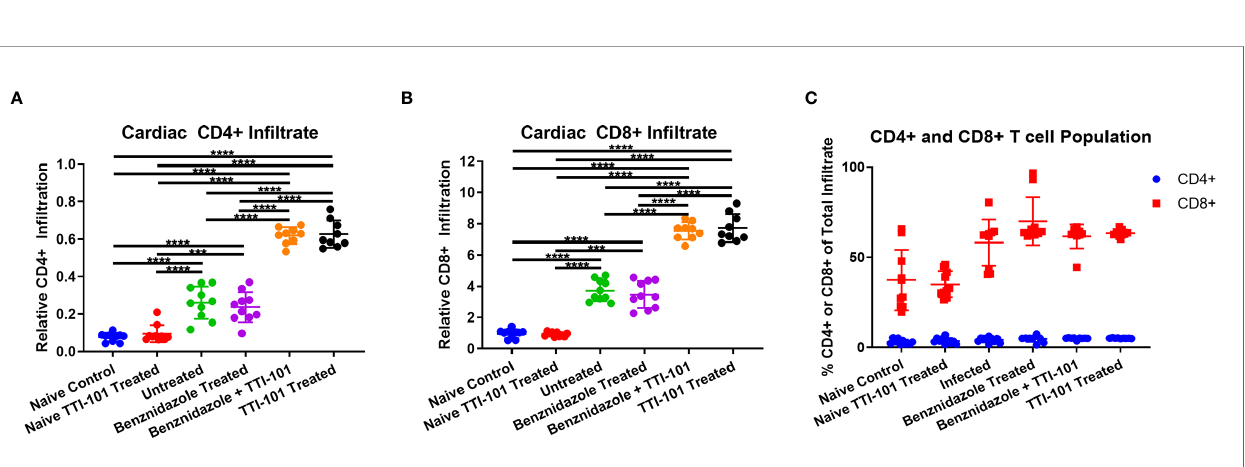
FIGURE 6 | CD4 and CD8 staining of in fl ammatory in fi ltrate in cardiac tissue. Immunohistochemistry was performed on cardiac tissues from groups exhibiting myocarditis, and images were processed for the measurement of relative CD4+ and CD8+ populations. The relative CD4+ (A) and CD8+ (B) stained cells are depicted as a percent of total tissue, measured from heart samples from all treatment groups. Comparison of CD4+ and CD8+ percentages of total cellular in fi ltrate (C) is shown. Error bars represent SD. Data were analyzed with Student ’ s t-test; ***p < 0.001, ****p <